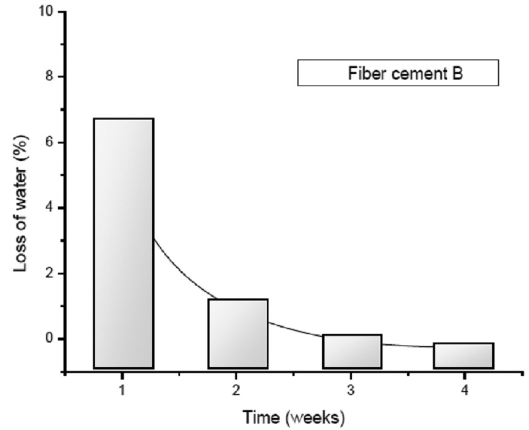
Figure 6. Loss of water evolution up to 28 days – fiber cement B.